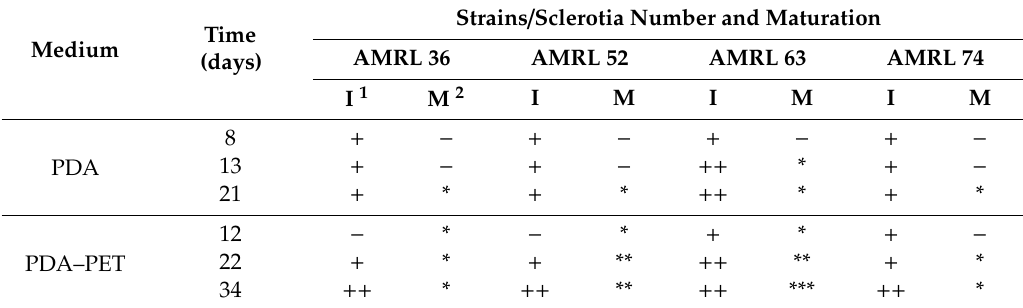
Table 4. Sclerotia formation and maturation of yellow (AMRL 36, 52) and black (AMRL 63, 74) morel strains grown on PDA medium, with and without polyethylene terephthalate (PET) membrane. Strains / Sclerotia Number and Maturation Time Medium AMRL 36 AMRL 52 AMRL 63 AMRL 74 (days) I 1 M 2